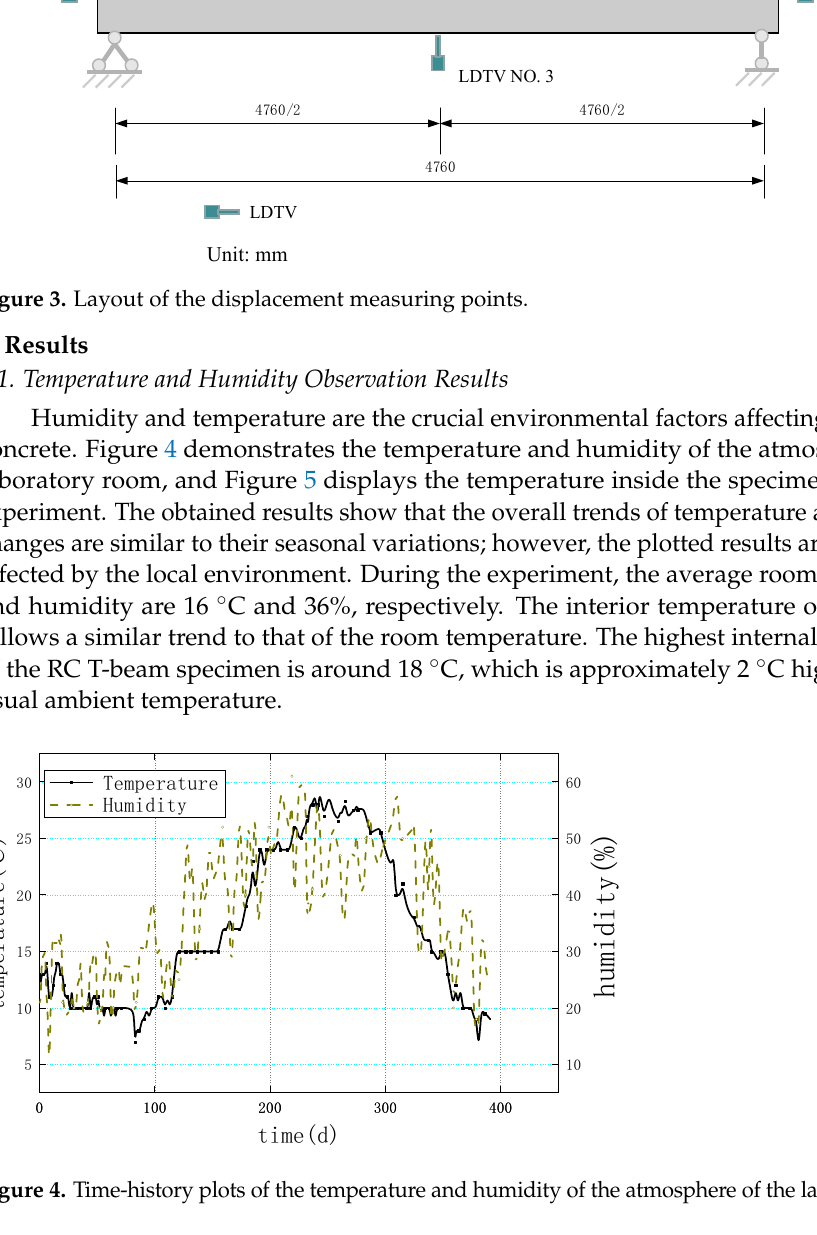
Figure 3. Layout of the displacement measuring points.